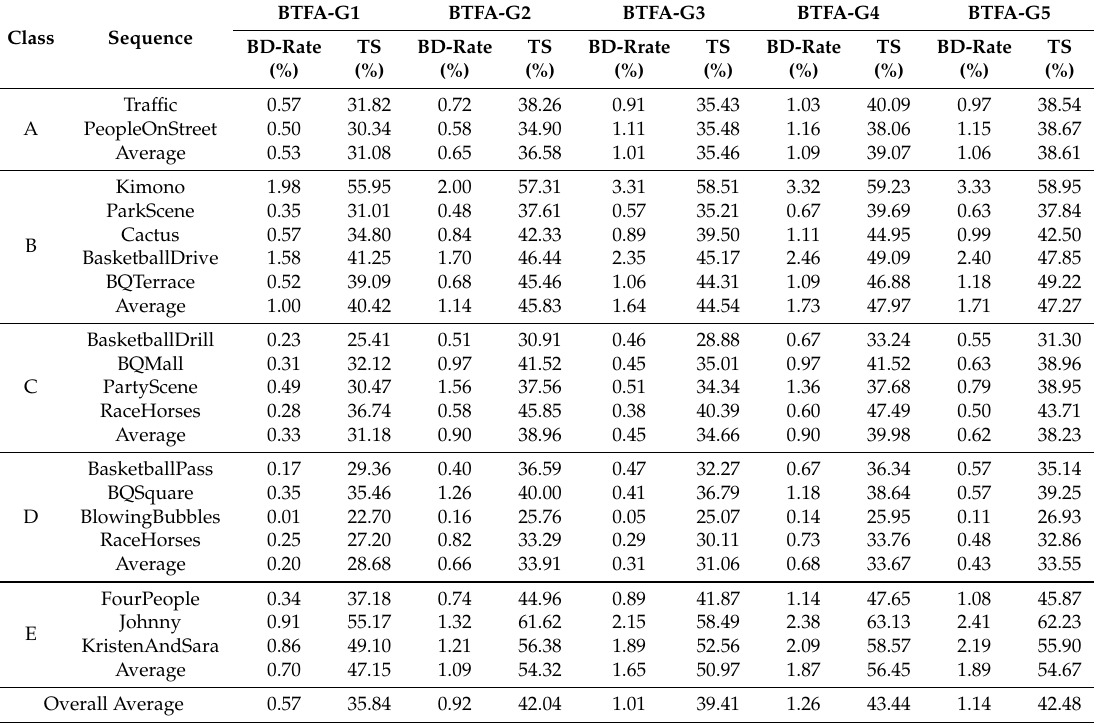
Table 4. BD-rate loss and time saving results of bagged trees based fast approach (BTFA) under different threshold